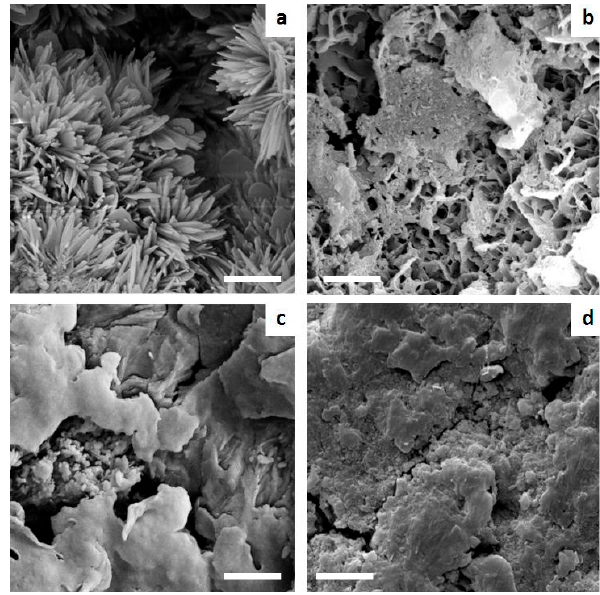
Figure 11. XRD patterns of Sr2 and KyphOs FS cement. ( a ) Cements hardened in vitro; and ( b ) explanted samples treated with both cements. Peaks legend: α TCP ( • ), β TCP ( □ ), HA (×), SrCO 3 (*), Mg 3 (PO 4 ) 2 ( ), MgHPO 4 (+), aluminum of the sample-holder support ( (cid:78) ). (cid:35)